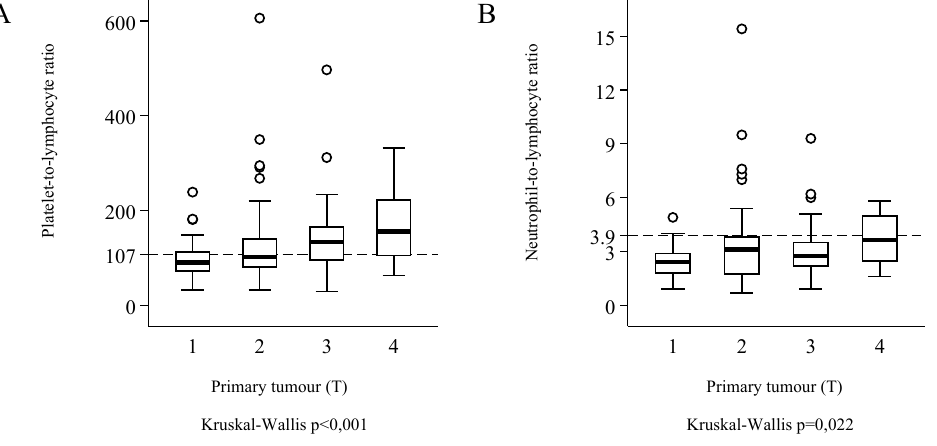
Figure 3. The platelet-to-lymphocyte ratio ( A ), and the neutrophil-to-lymphocyte ratio ( B ) in subgroups defined according to the stage and the location of the primary tumour (T).